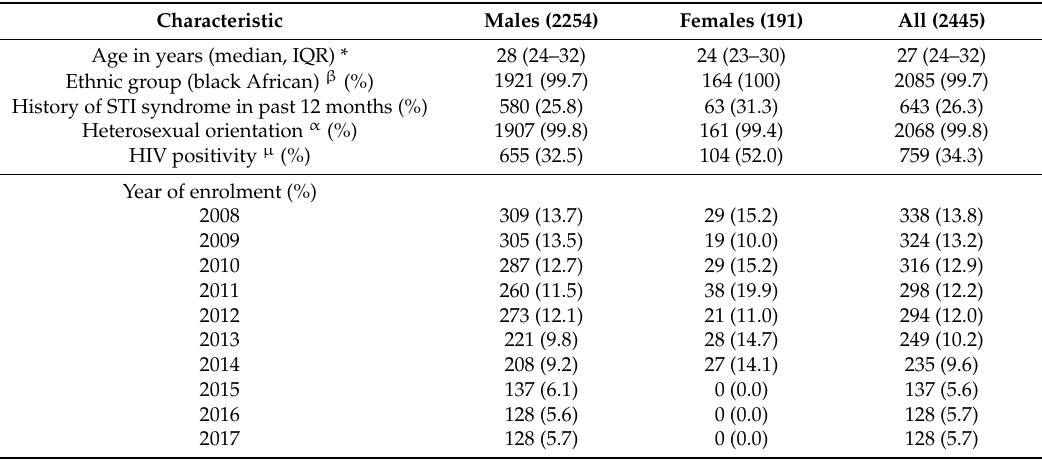
Table 1. Demographic and clinical characteristics of participants with gonorrhoea, Johannesburg, 2008–2017. Characteristic